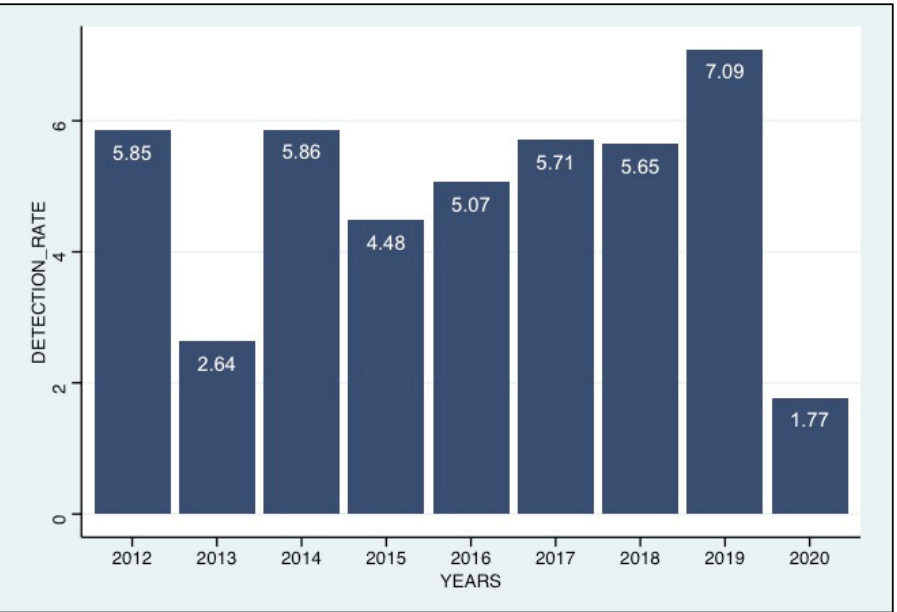
Figure 1. Annual trends in HcoV positivity rates (positives/samples tested), 2012–2020.